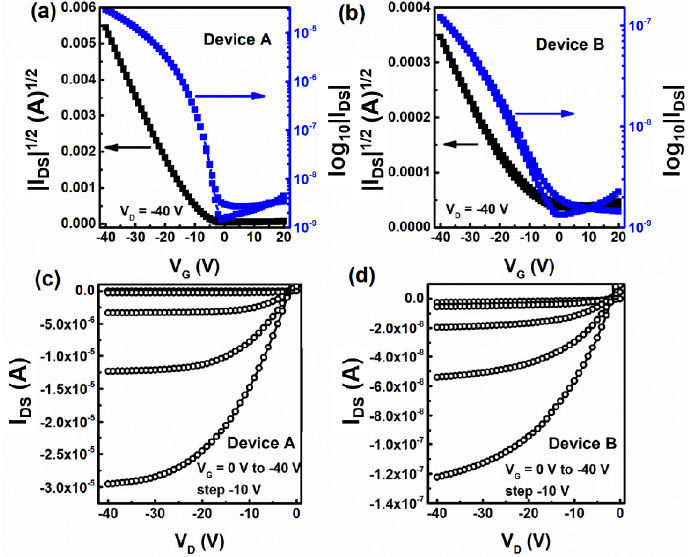
Figure 2. ( a , b ) Typical transfer curve I DS -V G , and ( c , d ) output curve I DS -V D of devices A and B, respectively.